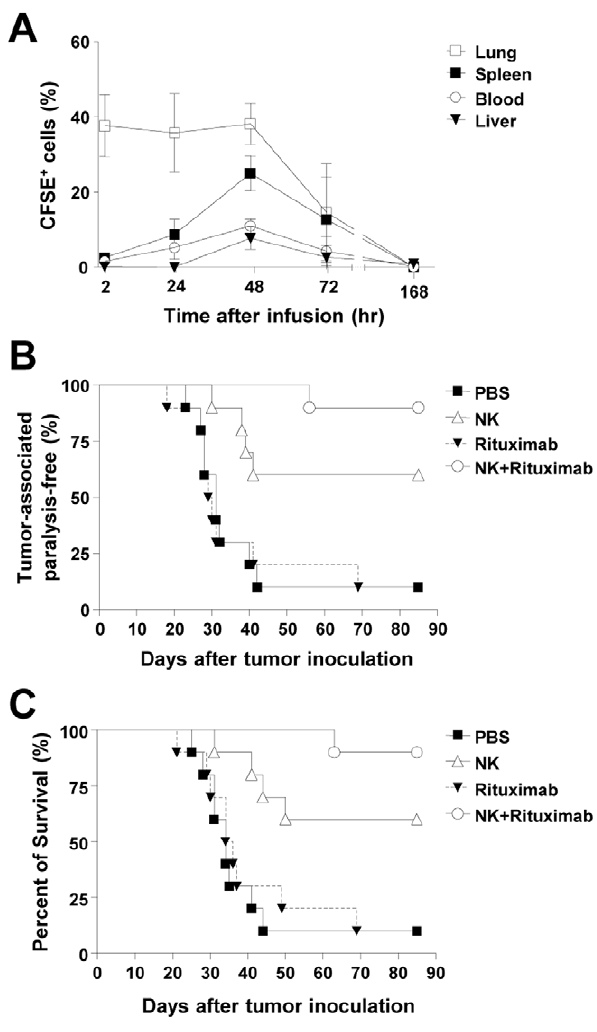
Figure 5. In vivo distribution and anti-tumor efficacy of expanded NK cells in SCID mice. (A) CFSE-labeled NK cells (2 6 10 7 cells/mouse) were intravenously injected into SCID mice. Mice were sacrificed at 2, 24, 48, 72 and 168 h, and the percentage of CFSE + cells in lungs, spleen, peripheral blood and liver was analyzed in lymphogating by flow cytometry (n=4). Each graph represents mean 6 SEM. (B–C) SCID mice were injected intravenously in the tail vein with 1 6 10 5 Raji cells and 1 6 10 7 expanded NK cells in 400 m L of PBS on day 0 (n=10/ group). Three additional doses of expanded NK cells (1 6 10 7 cells/ mouse) were administered within nine days. The monoclonal anti-CD20 antibody, rituximab (0.01 m g/mouse) was subcutaneously injected at the time of the first administration of expanded NK cells. Tumor- associated paralysis (B) and survival (C) were monitored. The efficacy test was confirmed by additional set of experiment using 10 mice per each group, and the representative set of the data is presented.